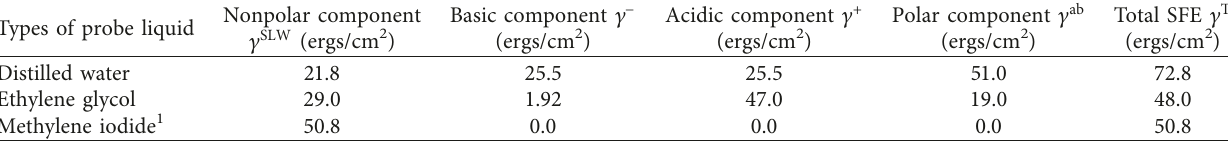
Table 3: Surface free energy characteristics of probe liquids.